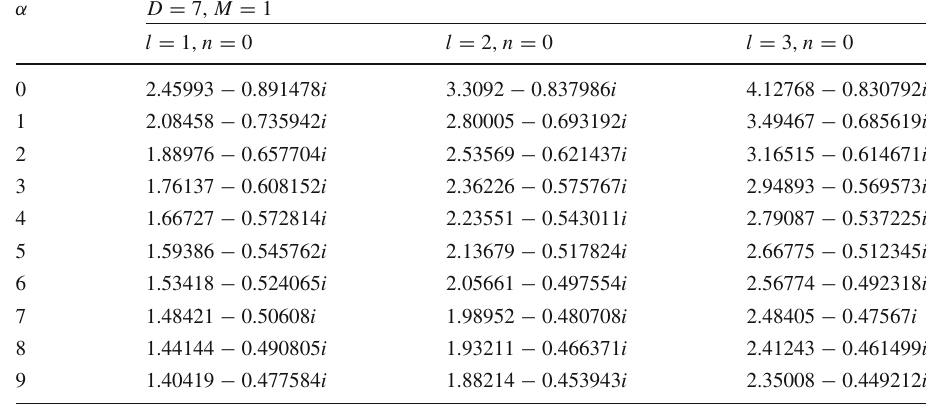
Table 4 The quasinormal mode frequencies of massless scalar field perturbations calculated by the sixth-order WKB approximation for the seven-dimensional Schwarzschild STVG black hole, where α = 0 corresponds to the case of Einstein’s gravity